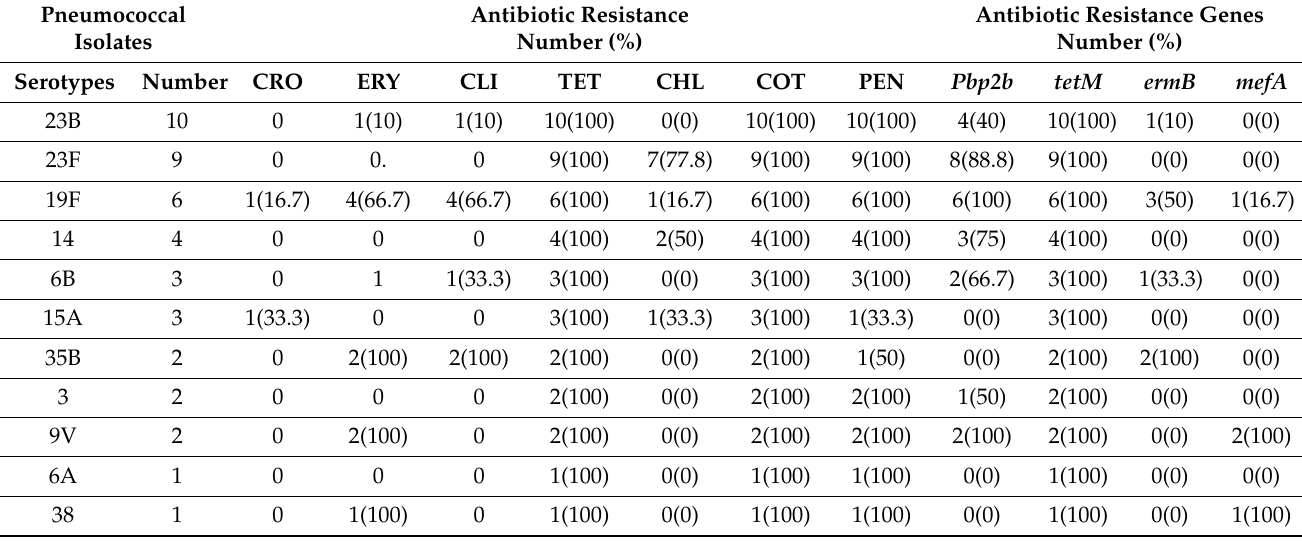
(Table 1). PCV13 covered 63.6% of the identified serotypes. Table 1. Distributions of MDR serotypes by antibiotic resistance patterns and prevalence of resistance